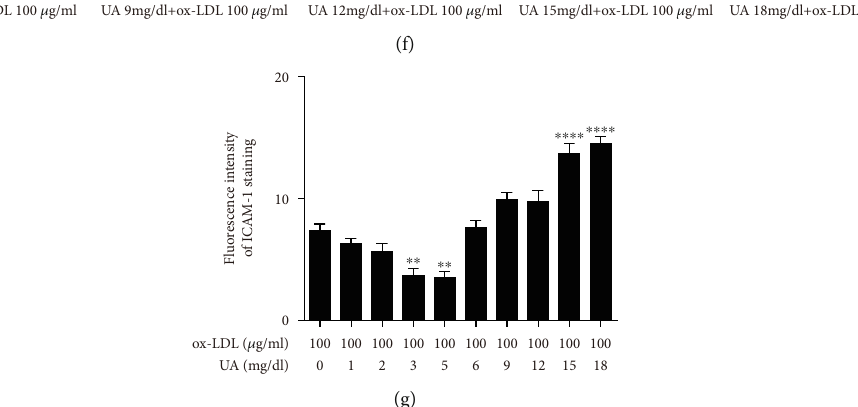
Figure 3: Changes of HUVECs under the stimulation of di ff erent concentrations of uric acid and fi xed concentration ox-LDL. HUVECs were pretreated with 0, 1, 2, 3, 5, 6, 9, 12, 15, and 18 mg/dL uric acid 2h before 100ug/mL ox-LDL stimulated. Changes in (a) cell morphology in di ff erent groups. Scale bar = 200 μ m. (b) Cell survival rate in di ff erent groups by CCK-8 assay. (c) MDA level in di ff erent groups. (d, e) DHE immuno fl uorescence image and densitometry analysis of immuno fl uorescent intensity of DHE. Scale bar = 50 μ m. (f, g) ICAM1 immuno fl uorescence image and densitometry analysis of immuno fl uorescent intensity of ICAM1. Scale bar = 50 μ m. DHE: dihydroethidium; HUVECs: human umbilical vein endothelial cells; ox-LDL: oxidized low-density lipoprotein; MDA: malondialdehyde. The statistical analyses were done using GraphPad Prism V-7.0 software. Data are expressed as the mean ± standard deviation ( n = 3 ). One-way ANOVA was used in statistical analyses ( n = 3 /group). ∗ P < 0 : 05 , ∗∗ P < 0 : 01 , ∗∗∗ P < 0 : 001 , and ∗∗∗∗ P < 0 : 0001 versus the